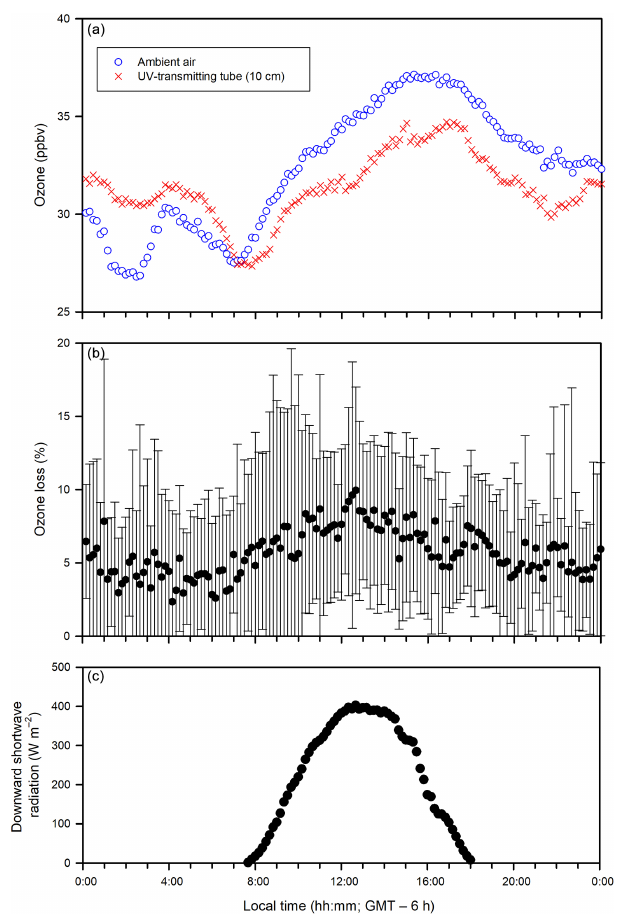
Figure 7. Diurnal patterns (averaged over 24 January to 17 March whenever the measurement was available) of (a) ozone concen- trations in the ambient air and the in-tube air inside the UV- transmitting tube (10cm above the sea ice), (b) ozone loss (%) (measured as the ozone difference between the ambient air and the in-tube air inside the UV-transmitting tube), and (c) downward shortwave